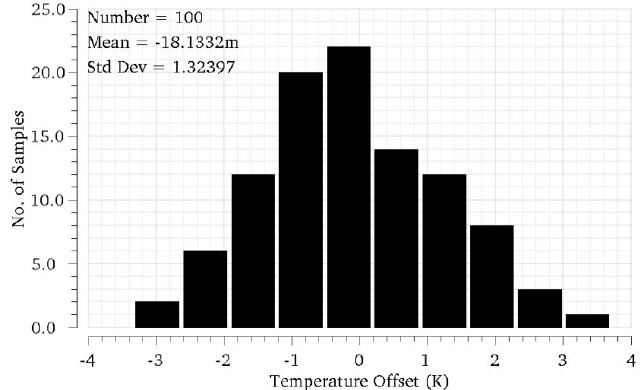
Figure 11. Histogram of the input-referred offsets of the core sensor circuit at balance, Δ T Q = 0 K, produced by manufacturing variability. produced by manufacturing